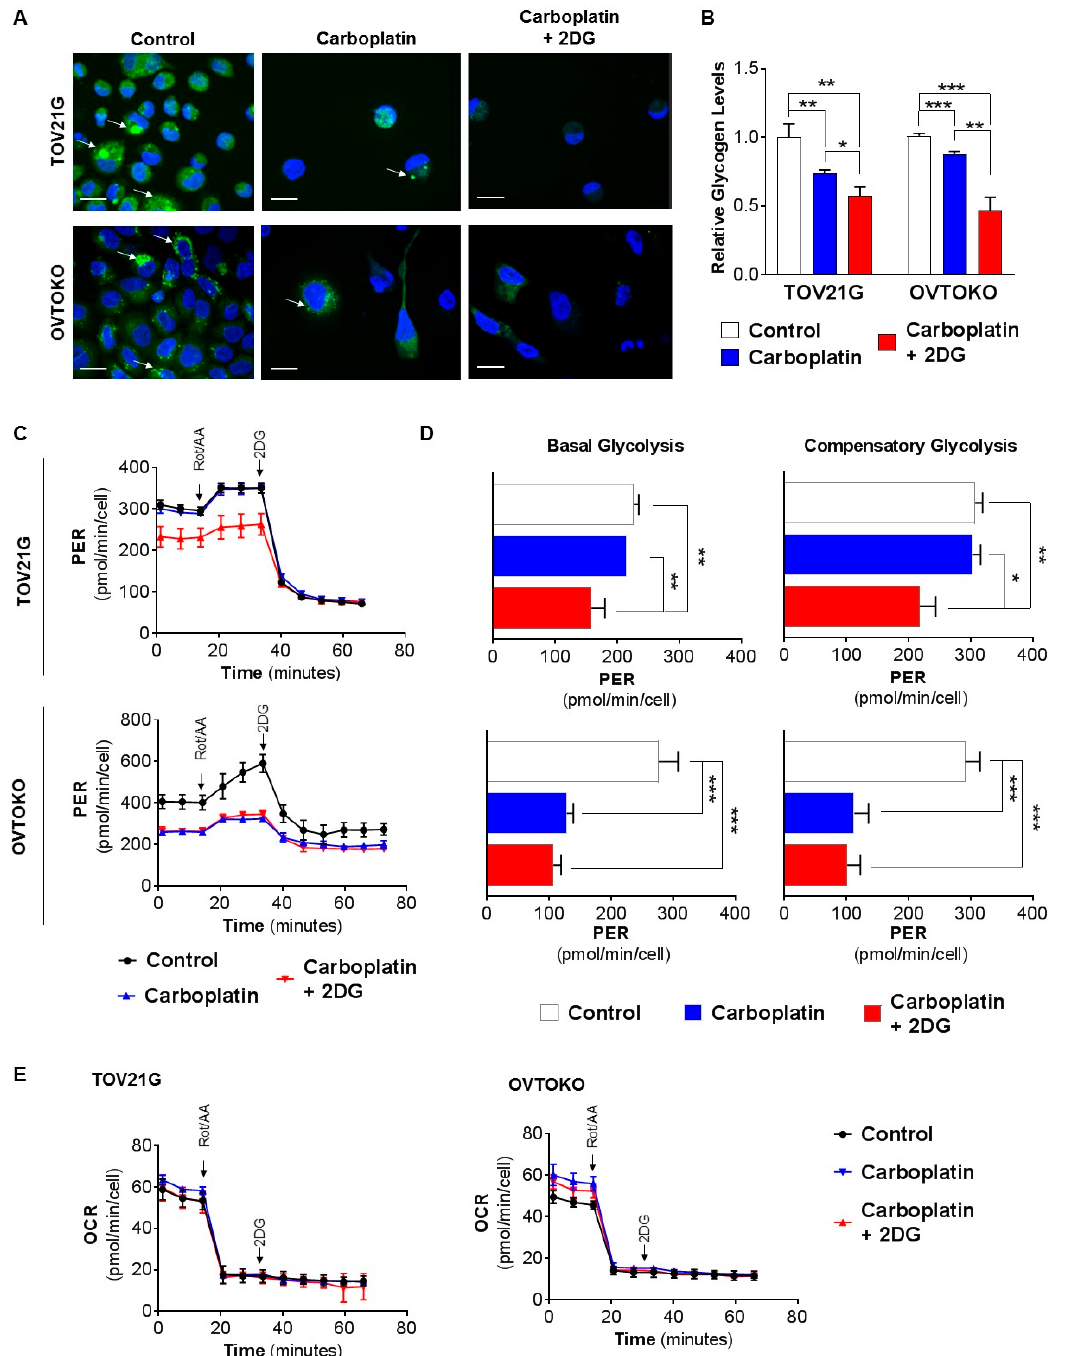
Figure 3. In combination with carboplatin, 2DG reduces glycogen levels in OCC cells in vitro. ( A , B ) Cells were treated for 72 h with PBS, carboplatin (GI 50 concentration determined in Figure 2A), or carboplatin and 2DG (0.6 mM). ( A ) Confocal microscope images of cells incubated with green fluorescent 2-NBDG for 3 h. Carboplatin and carboplatin/2DG treatments considerably reduced cell numbers, which was accompanied by reduced levels of 2-NBDG fluorescent signal per cell. Scale bar, 20 µm. ( B ) Graphs of relative glycogen levels quantified by analysis of lysates from cells collected prior to 2-NBDG treatments. ( C ) Graph of PER for TOV21G (upper) and OVTOKO (lower) cells treated with PBS, as control, carboplatin (GI 50 concentration determined in Figure 2A), or carboplatin, combined with 2DG (0.6 mM) for 24 h. ( D ) Graph of basal (left) and compensatory (right) PER for TOV21G (upper) and OVTOKO (lower) cells. Data were derived from (C). ( E ) Graph of OCR for TOV21G (left) and OVTOKO (right) cells treated with PBS, as control, carboplatin (GI 50 concentration determined in Figure 2A), or carboplatin combined with 2DG (0.6 mM) for 24 h. In C to E, the